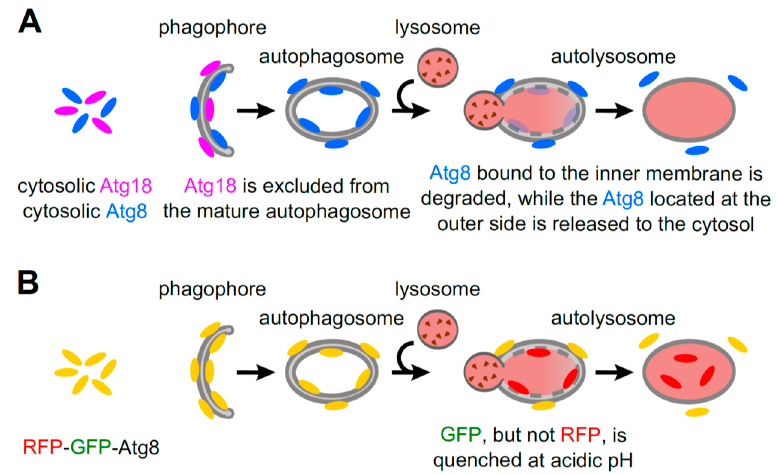
Figure 4. Atg18 and Atg8 as autophagic markers. ( A ) Atg18 is necessary for autophagosome formation, but it is released from mature autophagosomes. The cytosolic Atg8 protein is conjugated to phosphatidylethanolamine (PE) upon induction of autophagy, and is stably integrated into both the outer and the inner membranes of the phagophore. Therefore, the Atg8 fraction residing inside the autophagosome is degraded, together with other autophagic cargos, after lysosomal fusion; ( B ) red fluorescent protein (RFP)-GFP-Atg8 binds the autophagosomal membranes when autophagy is induced. Inside the autolysosomes, GFP is quenched due to the low pH, but RFP remains fluorescent. The increase in yellow and red Atg8 indicates induction of the autophagic flux, while the increase only in yellow Atg8 structures implies autophagic flux blockage.